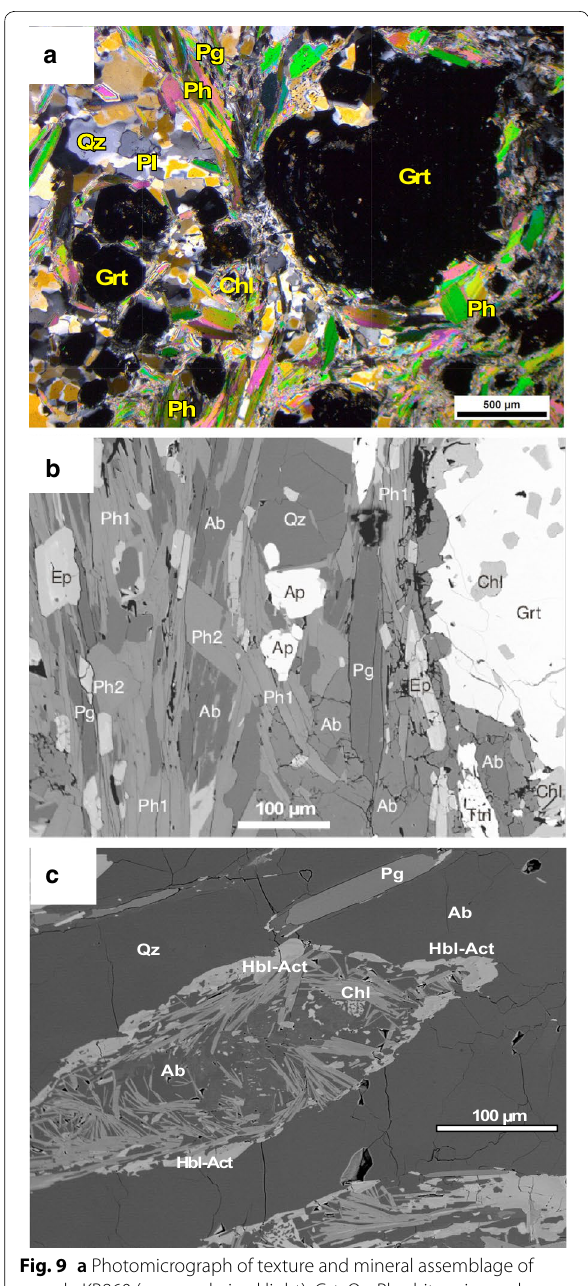
Fig. 9 a Photomicrograph of texture and mineral assemblage of sample KB860 (cross-polarized light): Grt, Qz, Pl, white mica and Chl. b Backscattered electrons (BSE) image of texture and mineral assemblage of sample OK-Z131. A predominant generation of foliation-parallel Ph (Ph1) with Si 3.3 has been overgrown by a = later generation of Ph with Si 3.1 (Ph2). c Backscattered electrons = (BSE) images showing a Chl–Ab pseudomorph after Gln in sample OK Z129. Scale bar 100 µm. The pseudomorph is rimmed by Mhb = = and